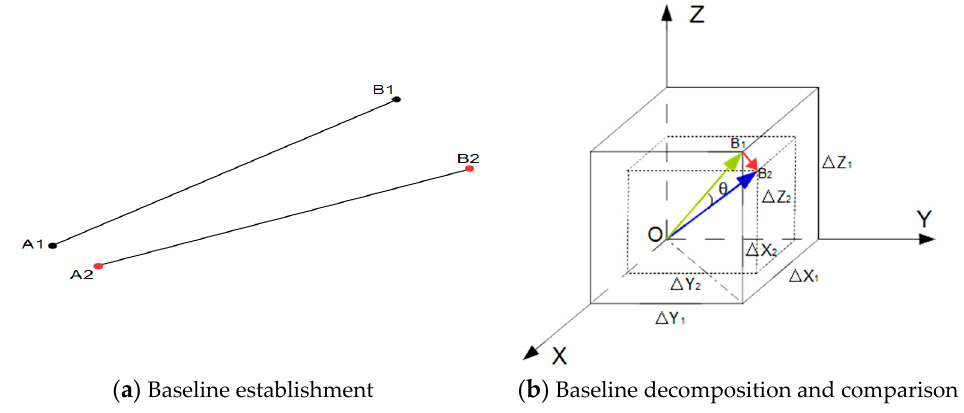
Figure 7. Baseline establishment, decomposition and comparison.